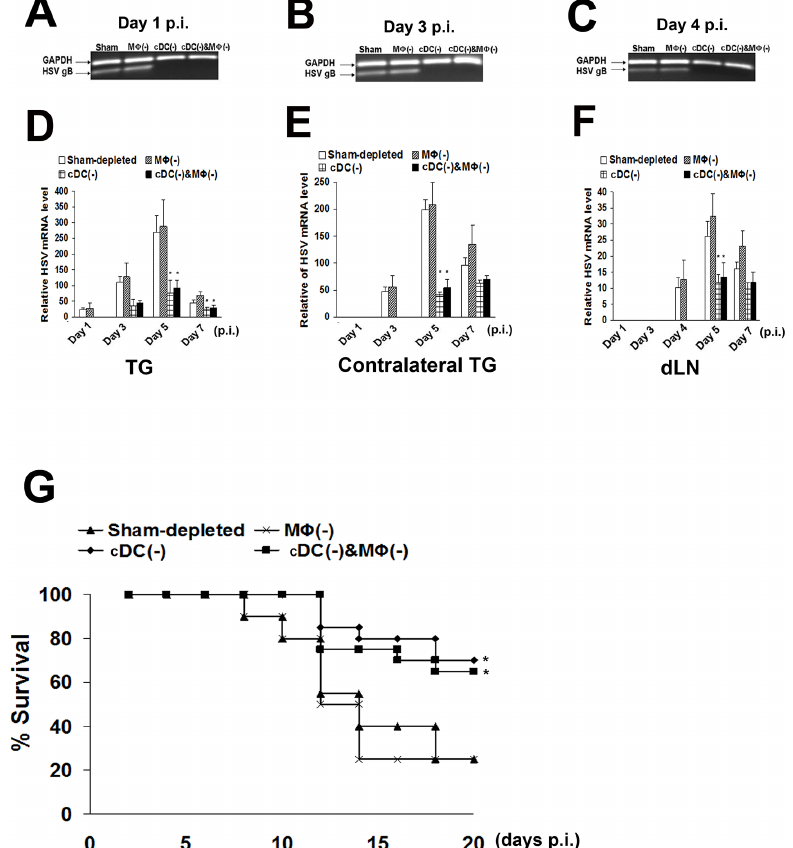
Fig 6. Corneal conventional dendritic cell depletion results in delayed and decreased systemic viral transmission and subsequent increase in survival rate after corneal HSV-1 infection. After corneal HSV-1 infection, trigeminal ganglions (TGs) or draining lymph nodes (dLNs) (n = 6/time point) were collected and HSV-1 mRNA levels were measured. The survival rates of infected mice were monitored (n = 20). A, D: On day 1 p.i, HSV mRNA was detected in the TGs of sham-depleted or M Φ -depleted mice, but not in cDC- depleted (single or double-depleted with M Φ ) mice. Viral mRNA was detected on day 3 p.i. in the TGs of mice with corneal cDC-depletion, but was significantly lower as compared to sham-depleted and M Φ -depleted mice. B, E: On day 4 p.i, viral mRNA was detected in dLNs of sham-depleted or M Φ -depleted mice, but not in mice with corneal cDC-depletion. However, on day 5 p.i., viral mRNA was detected in dLNs of mice with corneal cDC-depletion, but at significantly lower levels than in sham-depleted controls. C, F: HSV mRNA was also detected in the contralateral TGs with 2 days delay, and corneal cDC-depletion resulted in delayed and decreased virus levels. G: Survival rates of mice with corneal cDC-depletion or mice with corneal cDC/M Φ double-depletion were significantly increased as compared to sham-depleted mice, or M Φ -depleted mice. Each experiment, including the survival experiments, was replicated three times. * p < 0.05, # p < 0.01 compared with sham-depleted corneas (ANOVA-D, E, F, two-sided; Fisher Exact Probability Test-G). Data are shown as mean ±